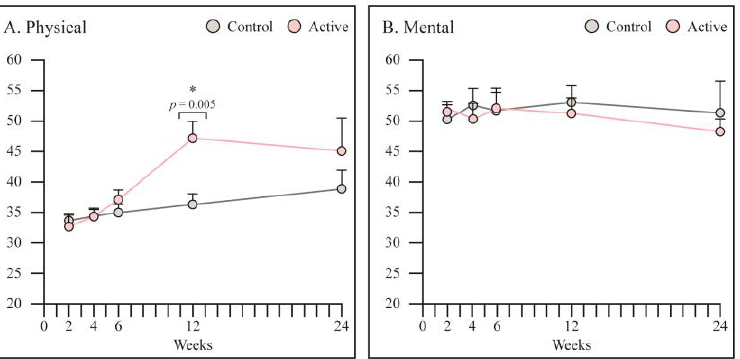
Figure 7. Assessment of patients physical and mental wellbeing using SF 12. ( A ) SF12 physical score was significantly higher in PEMF treated group at 12 weeks. ( B ) No differences were noticed in the SF12 mental score. Graphs are reported as mean ± SE. Student’s t -test. * Statistically significant.